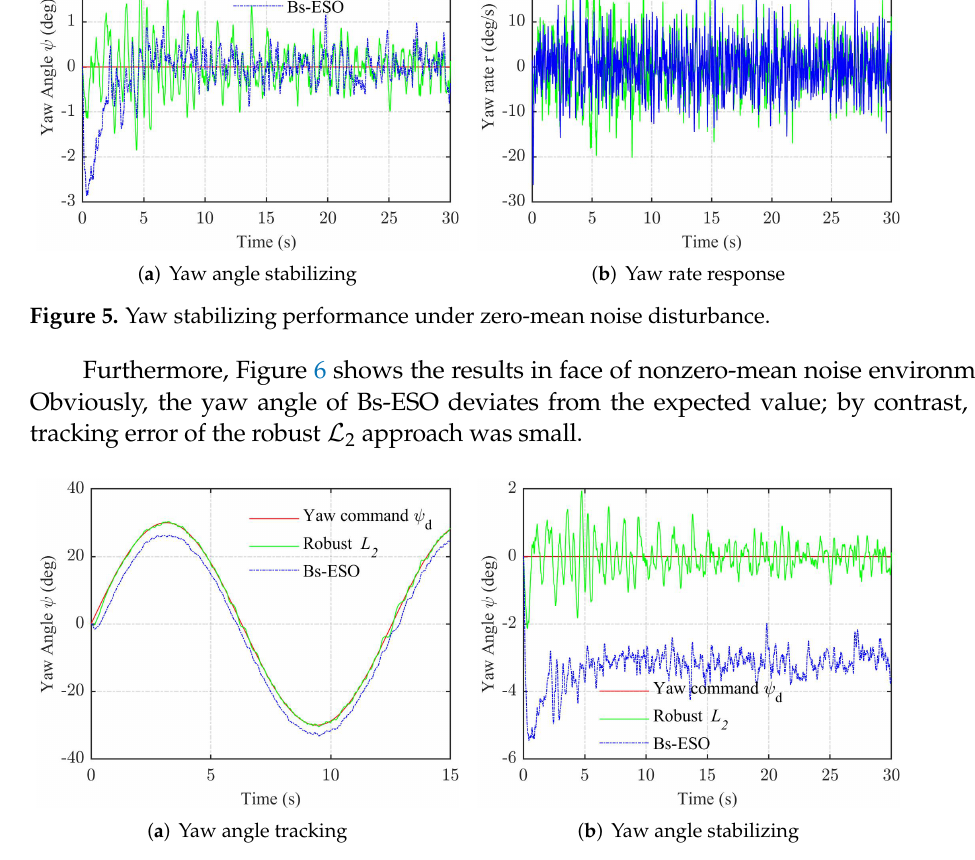
Figure 6. Yaw tracking and stabilizing under nonzero-mean noise disturbance. The second group of simulations verified the ability to resist motor fault disturbance.